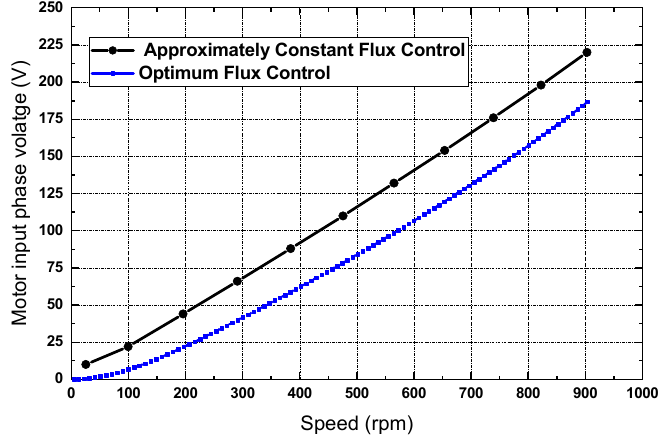
Figure 6. Motor input voltage variation with speed at approximately constant and optimum flux operation.